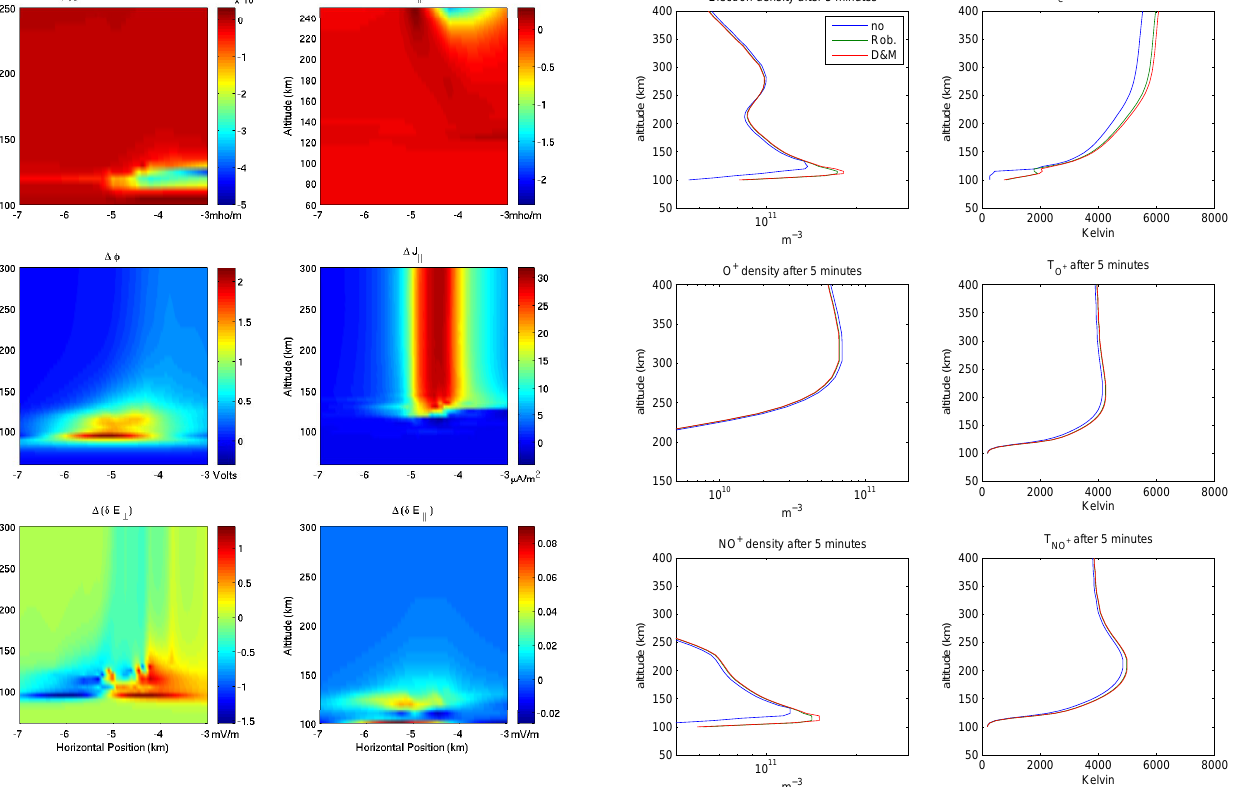
Fig. 11. Differences between various electrodynamical parameters for the two different wave heating rate expressions (case 2 results minus case 3 results) that we have considered in this work. Same presentation format as in Fig. 4 but with the differences instead of the actual quantities.